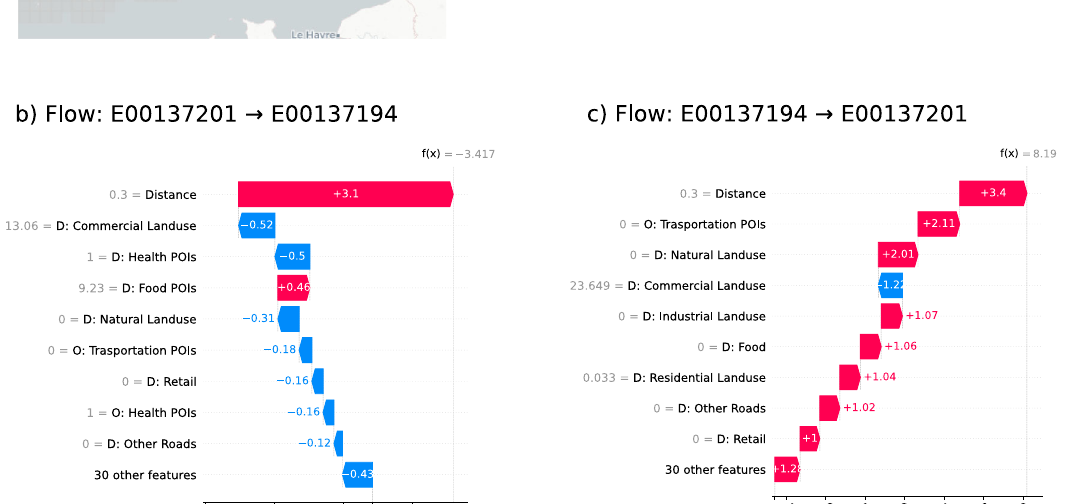
create an open source map of the world with geographic information collected from volunteers. The OSM data contain three types of geographical objects: nodes, lines and polygons. Nodes are geographic points, stored as latitude and longitude pairs, which represent points of interests (e.g., restaurants, schools). Lines are ordered lists of nodes, representing linear features such as streets or railways. Polygons are lines that form a closed loop enclosing an area and may represent, for example, land use or buildings. We use OpenStreetMap (OSM) data to compute the 18 geographic features for the origin and 18 for the destination. Regarding the